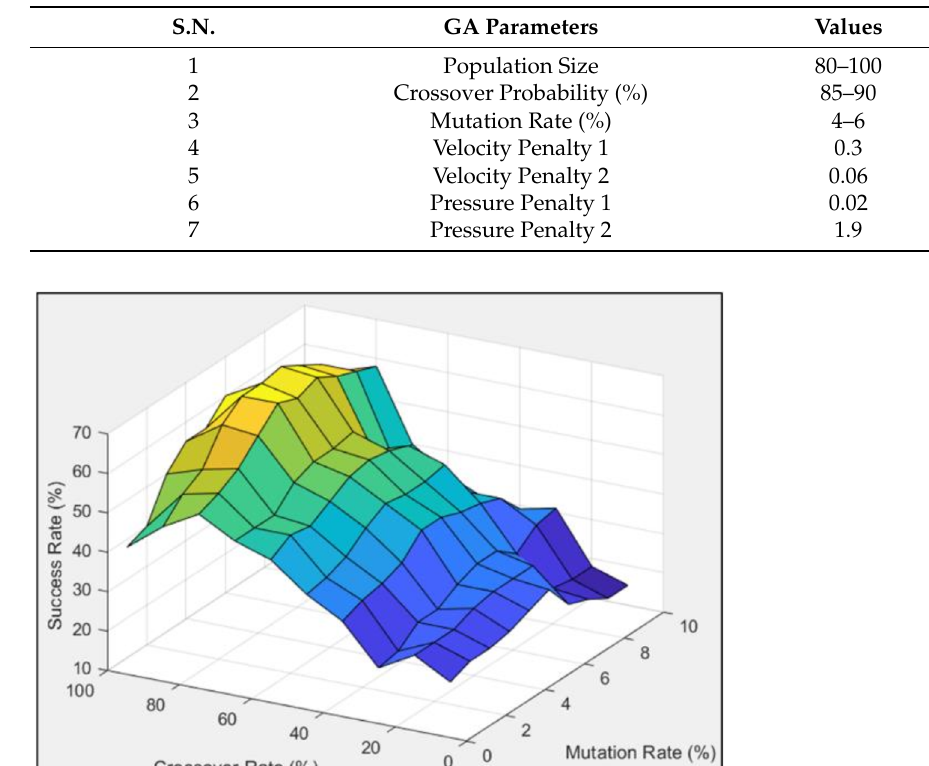
Table 3. Set of Genetic Algorithm parameters.